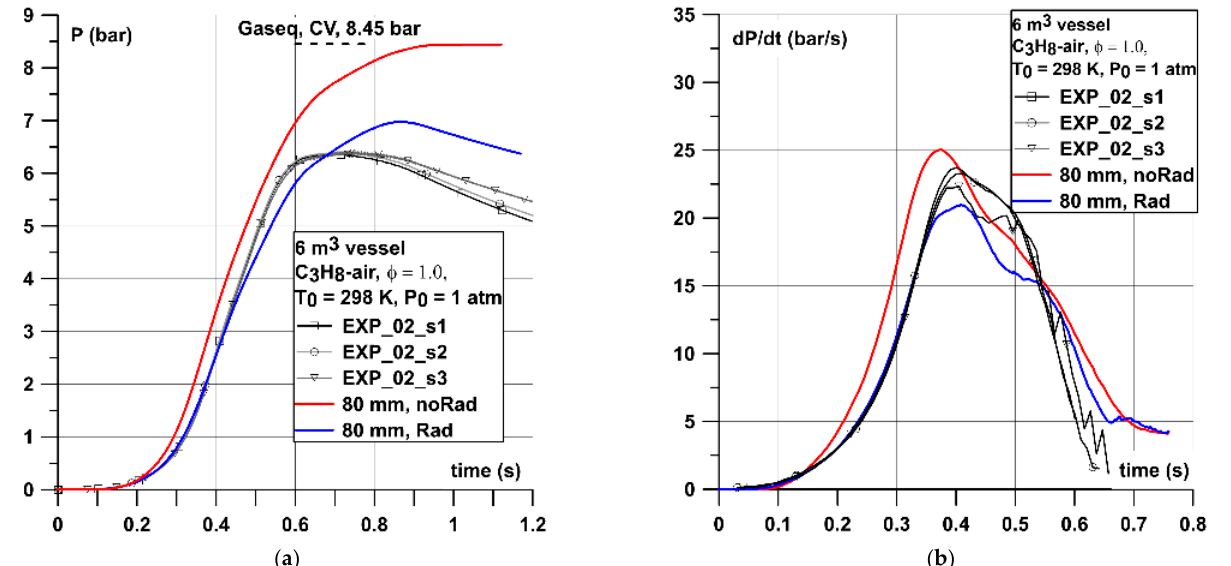
Figure 17. ( a ) Pressure and ( b ) dP/dt graphs for stoichiometric C 3 H 8 –air mixture in the 6 m 3 vessel.